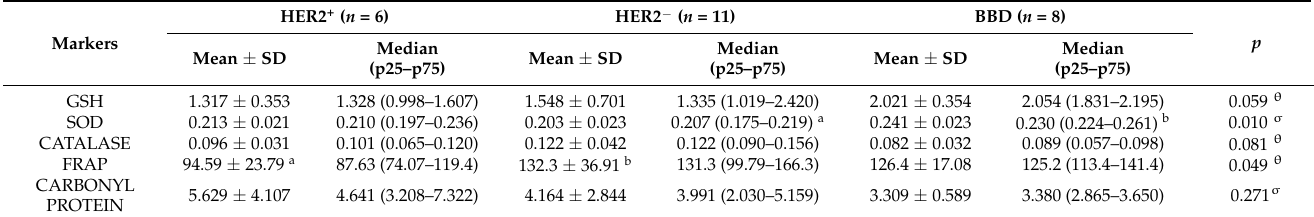
Table 4. Profile of redox status markers among women with breast cancer HER2 + , HER2 − and benign breast disease at a university hospital in Uberlandia, Minas Gerais, Brazil ( n =